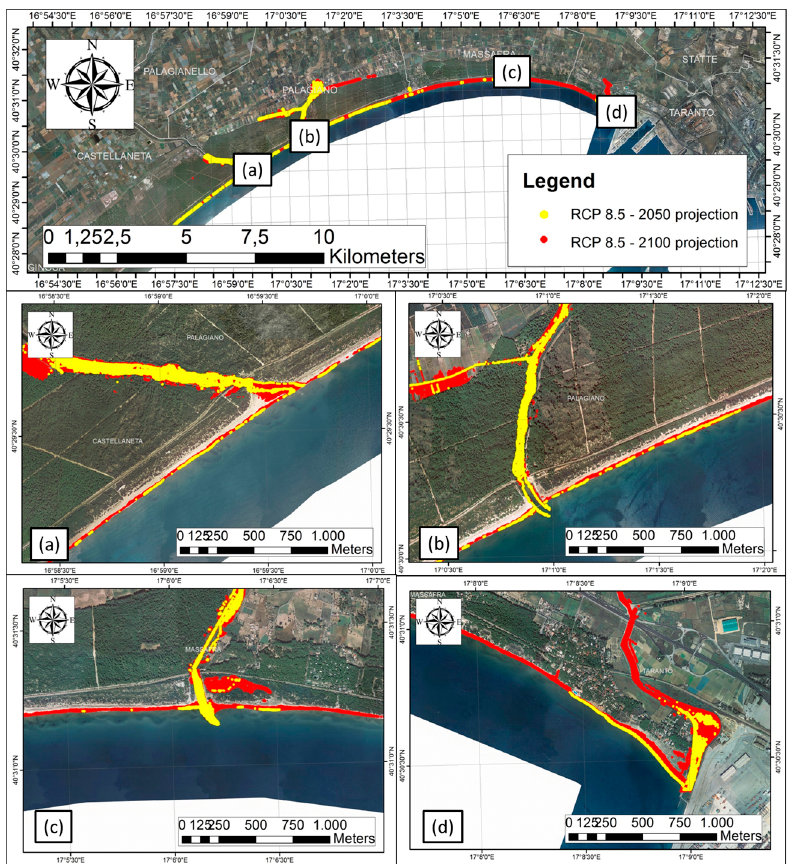
Figure 18. Submersion predictions for the coast around the Gulf of Taranto. Scenarios are relative to the AR 5 RCP 2.6 and RCP 8.5 projections of sea-level rise for 2050 and 2100 together with the VLM and horizontal displacement caused by shoreline change and sea-level rise: ( a ) the Lato River mouth; ( b ) the Lenne River mouth; ( c ) the Patemisco River mouth coastal stretch; ( d ) the Tara River mouth.